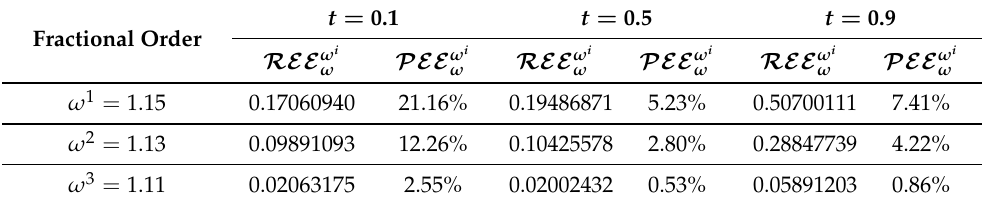
Table 1. The relative error and percent error estimations for ω = 1.1. t = Fractional Order